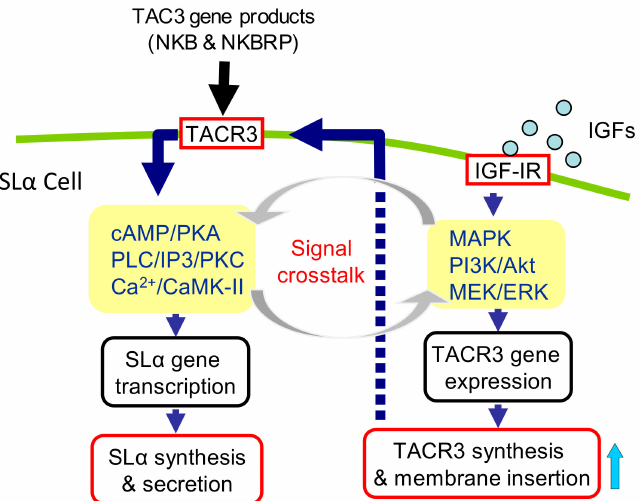
Figure 7. Working model of the potentiating e ff ect of IGF-I / -II on TAC3 gene product-induced SL α mRNA expression in grass carp pituitary: In grass carp, both TACR3 and IGF-IR were expressed in pituitary SL α cells. In grass carp SL α cells, IGF-I / -II could stimulate TACR3 mRNA expression via IGF-IR activation by functional coupling with the PI 3 K / Akt / mTOR, MKK / MAPK, and MEK 1 / 2 / ERK 1 / 2 pathways. The stimulation of TACR3 gene expression could contribute to the potentiating e ff ect of IGFs on NKBRPa- or NKBa-induced SL α mRNA expression, which were mediated by TACR3 via the PLC / IP 3 / PKC, AC / cAMP / PKA, and Ca 2 + / CaM / CaMK-II signaling pathways. Furthermore, the potentiating e ff ect of IGF-IR and TACR3 activation could also involve the functional crosstalk at the level of post-receptor signal transduction in grass carp pituitary.